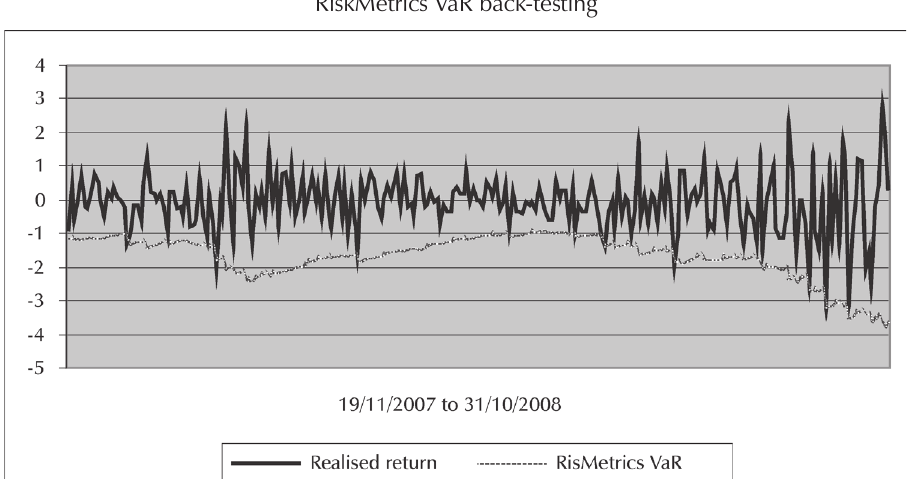
RiskMetrics VaR